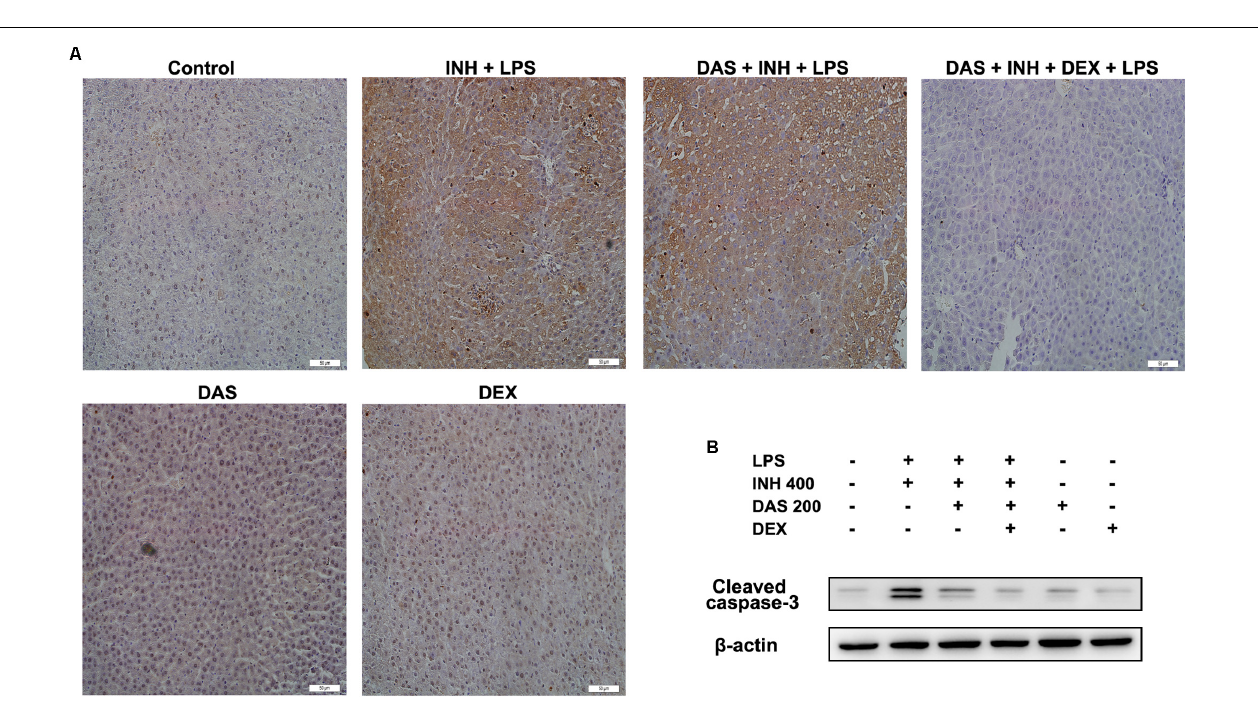
FIGURE 7 | Hepatocellular apoptosis following INH/LPS treatment with or without pre-addition of DAS and DEX. (A) TUNEL assay was conducted on liver slices; INH/LPS co-administration with or without DAS caused obvious positive TUNEL results (intensity of brown color indicating apoptotic action). In the meantime, pre-addition of DEX restrained INH/LPS tendency to induce apoptosis (absence of brown color). (B) Representative western blot analysis of cleaved caspase-3, β -actin used as internal